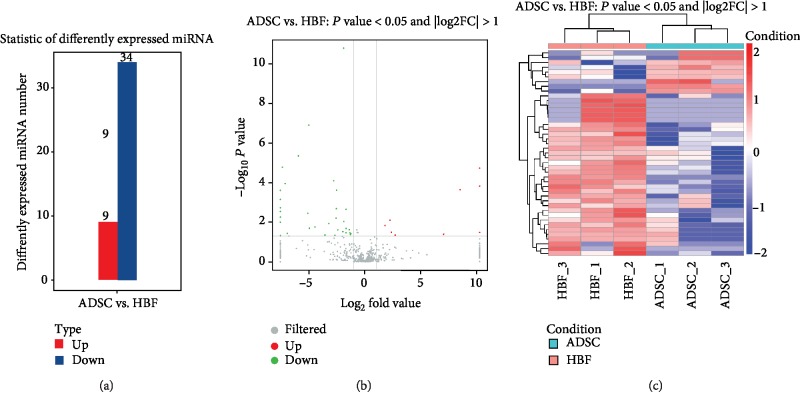
The differential analysis of miRNA. (a) Column graphs show screened differentially expressed miRNA in ADSC-Exo exosomes and HFF-Exo exosomes. (b) Volcanic maps show the overall distribution of differentially expressed miRNAs. Gray represents nondifferentiated miRNA, red represents upregulation of significant differences in miRNA, and green represents downregulation of significant differences in miRNA. (c) Heat map display expression pattern clustering analysis. Red indicates high expression and blue indicates low expression.